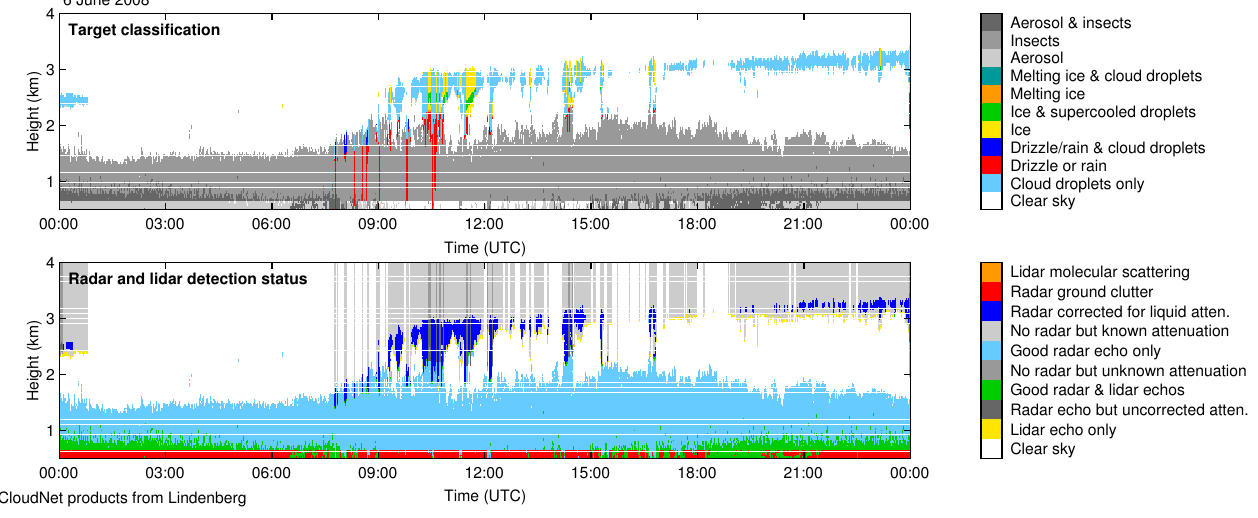
Fig. 1. Cloudnet classification product for Lindenberg on 6 June